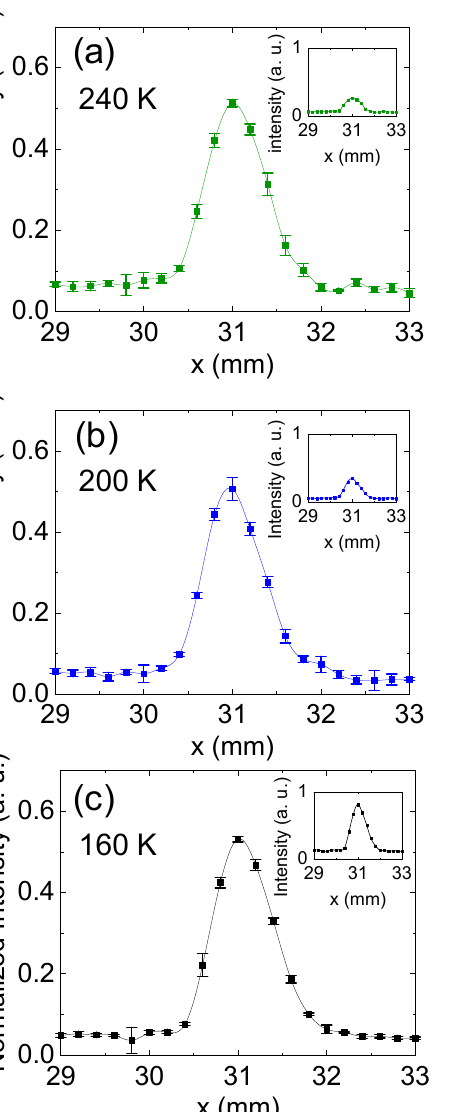
Figure 6. Schematic illustration of extraction of vertical and horizontal profiles from THz image.